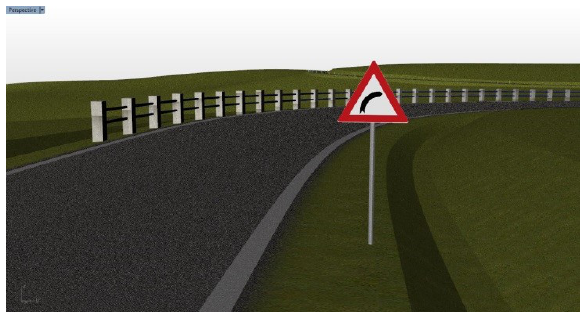
Figure 8. Complete road track model.